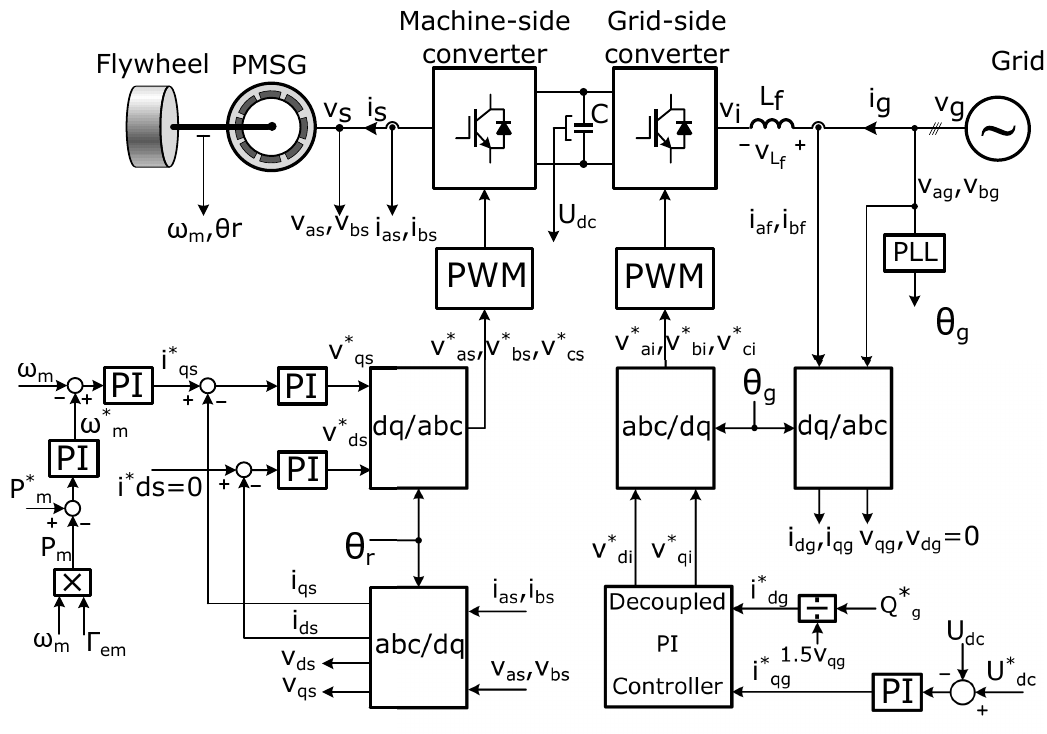
Figure 9. Flywheel general control scheme with PI